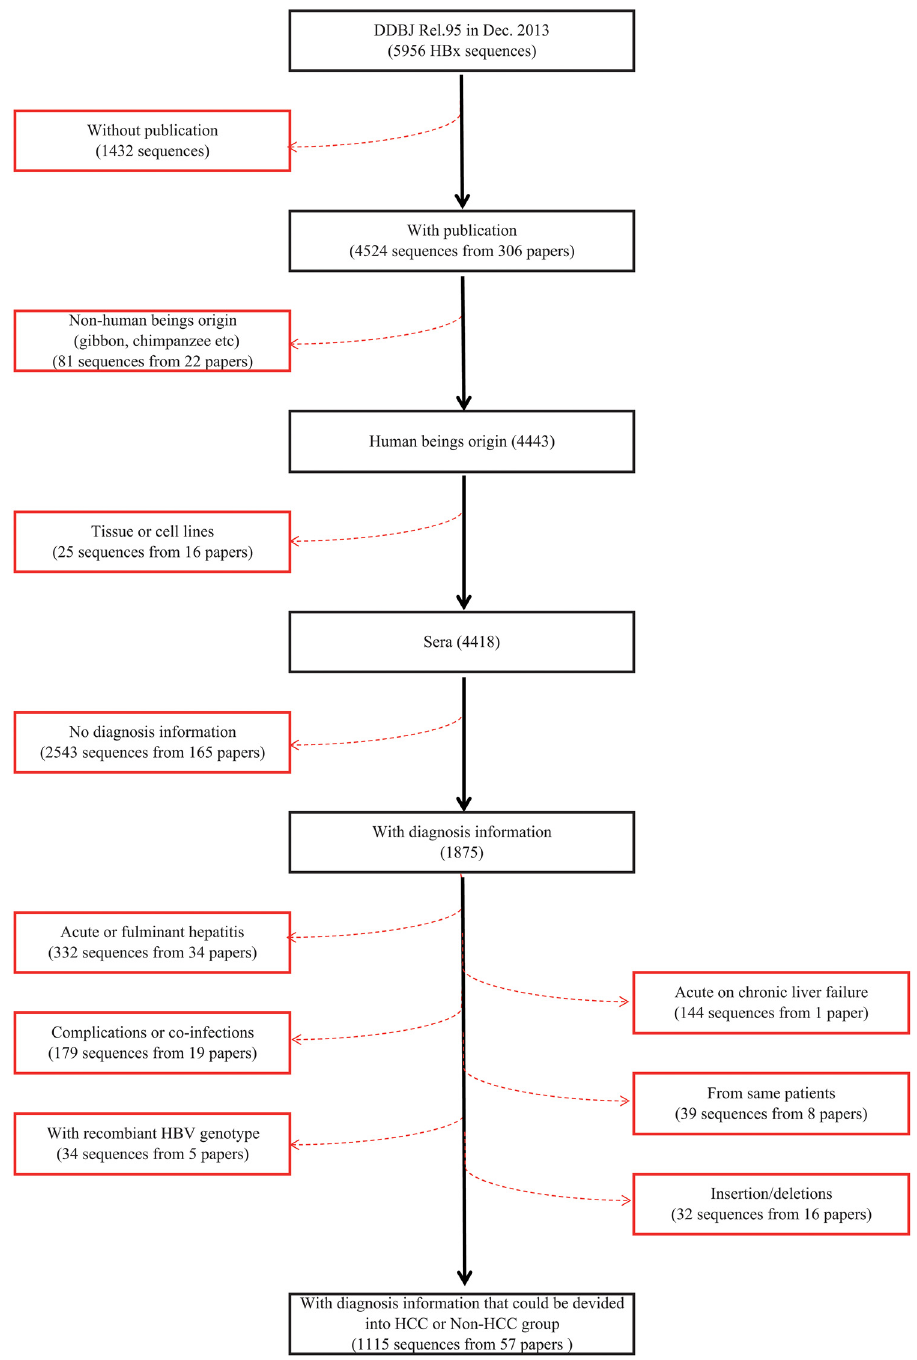
Fig 1. Flowchart for screening HBx sequences downloaded from an online global database. We downloaded HBx sequences from Hepatitis Virus Database (HVDB, http://s2as02.genes.nig.ac.jp/). The version we exploited was DDBJ Rel. 95, containing 5956 HBx sequences in total. Sequences were then screened successively by attached information such as publication, origin, and diagnosis. Sequences enrolled should be 1) Full length HBV X sequence; 2) human sera origin; and 3) with diagnosis information and thus could be classified to non-HCC or HCC group. Finally 1115 full length HBx sequences (HCC, 161; and Non-HCC, 954) from 57 publications were extracted for further